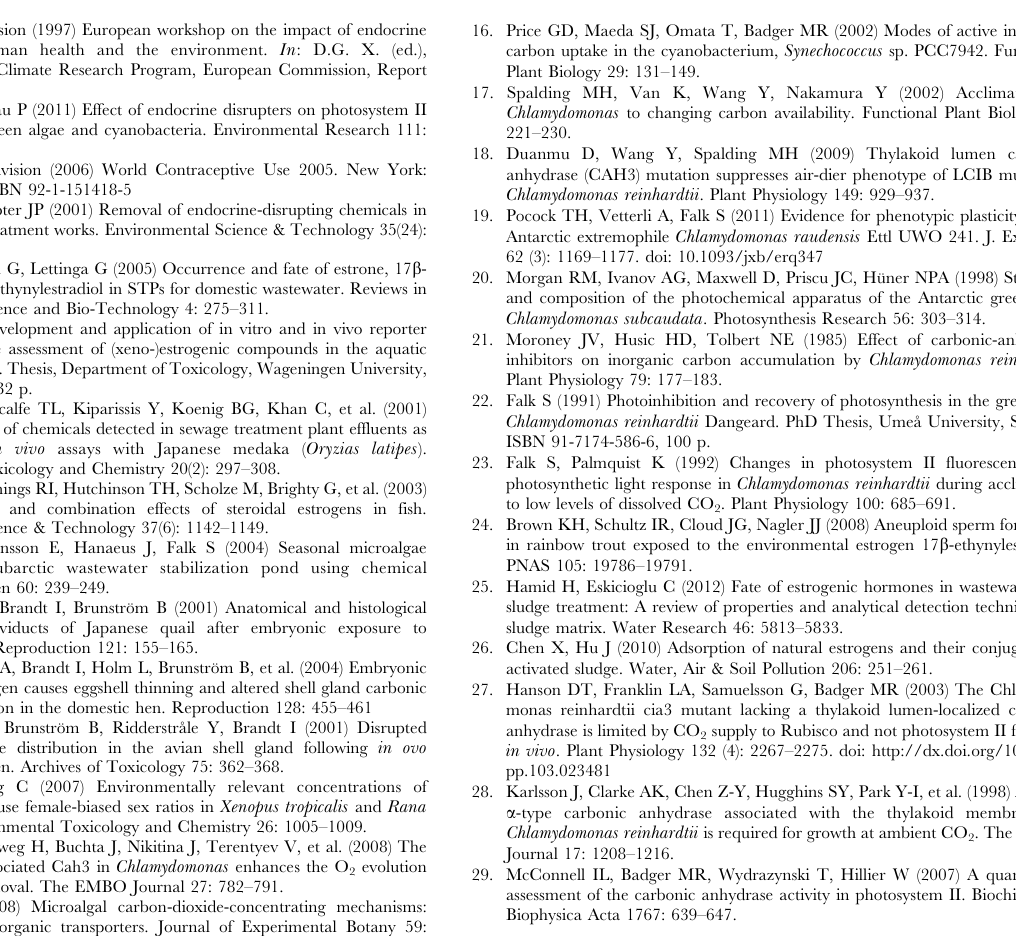
Figure S1 The file is the unedited X-ray film of the Western blot used for figure